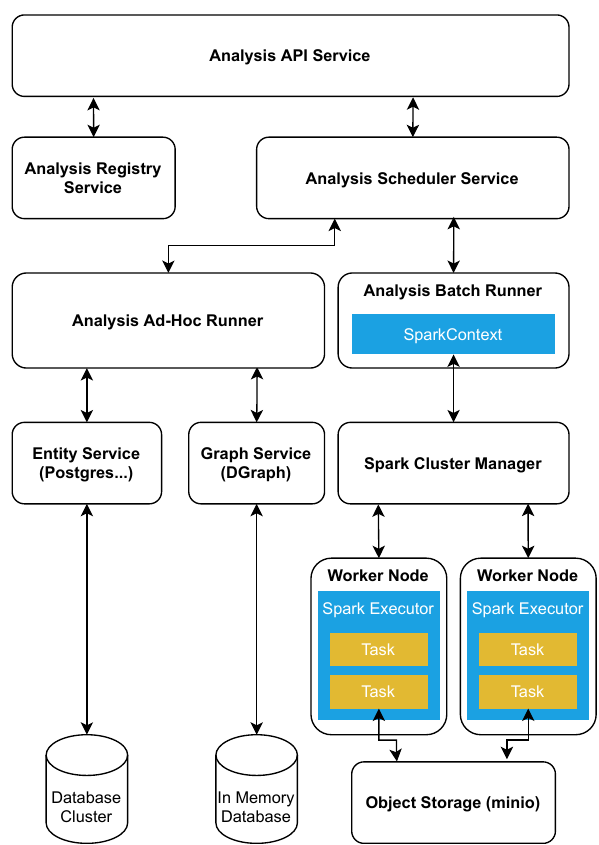
Figure 9. Analysis